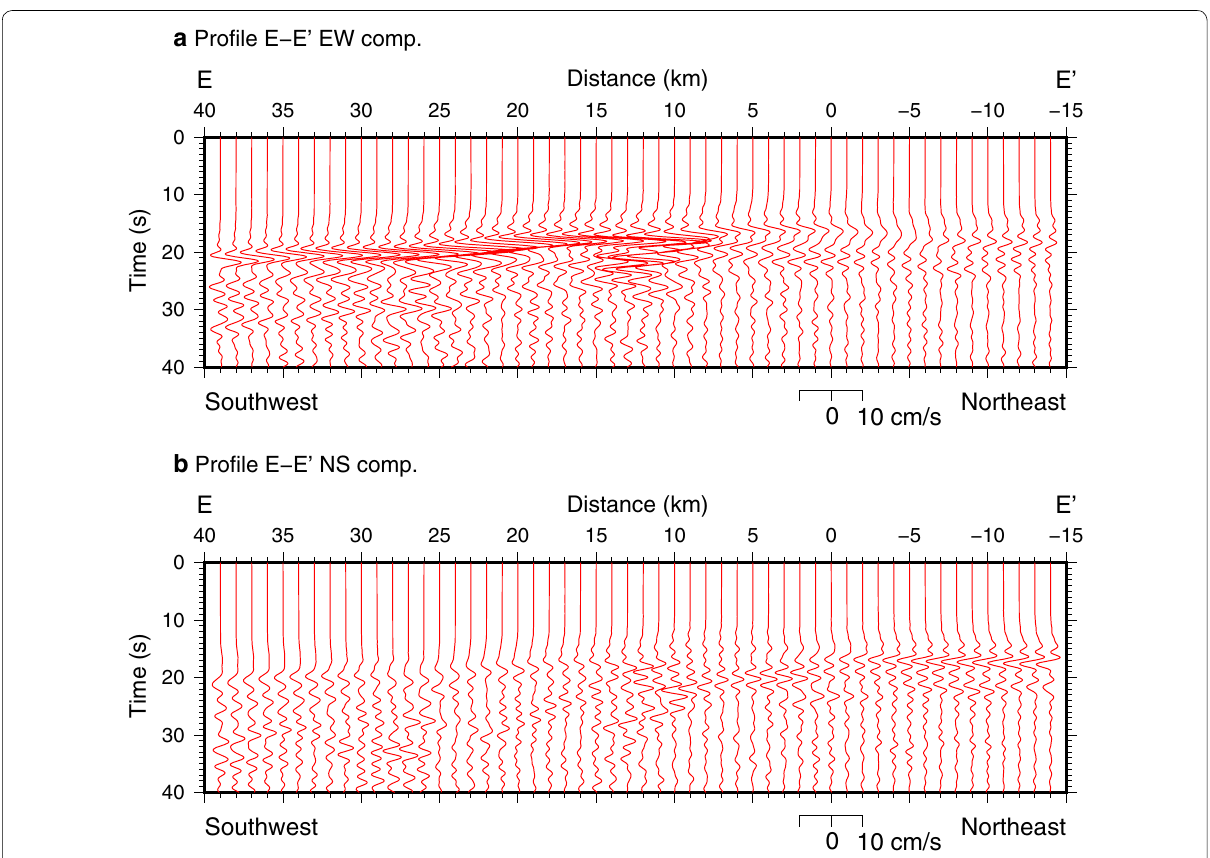
Fig. 10 Pasted up of the simulated seismic velocity waveforms along the profile E–E ′ . The location of the profile line is shown in Fig. 11. a EW, b NS component. The origin (0 km) of the horizontal axis corresponds to the location of the epicenter, which was indicated by the star in Fig.